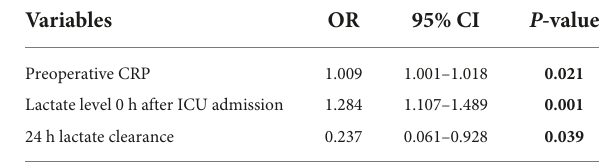
TABLE 6 Multivariate analysis of risk factors associated with 30-day mortality in patients with